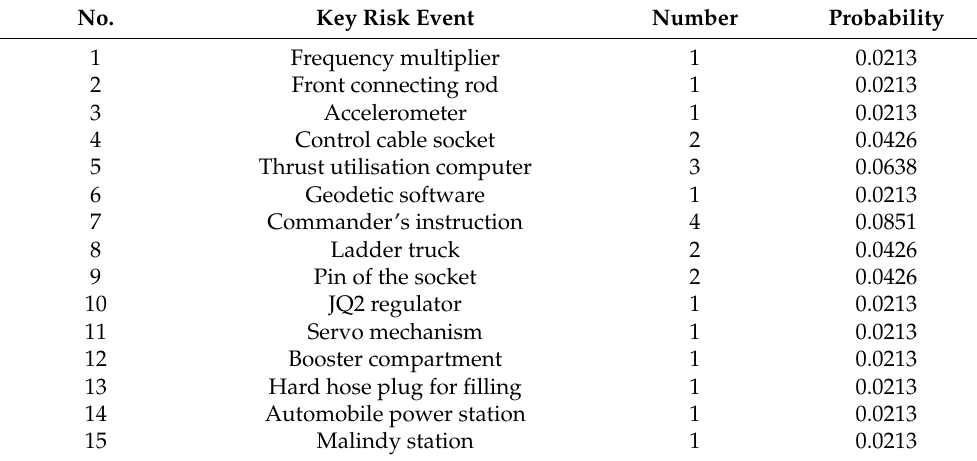
Table 3. Prior probability of the key risk events.